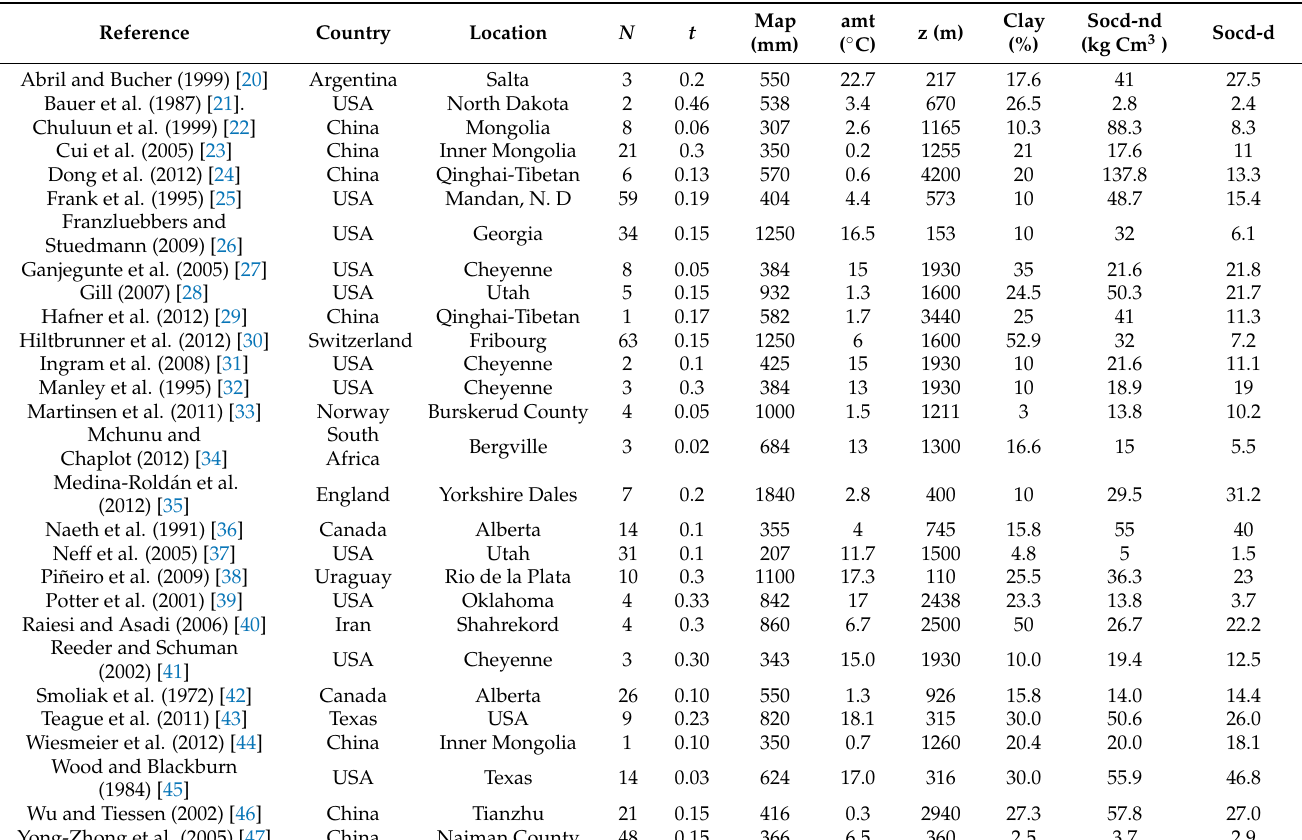
Table 1. Effect of the destruction of grassland on soil organic carbon (SOC) stocks on major environmental controls up to 0.3 m in grasslands degraded and non-degraded topsoil worldwide.